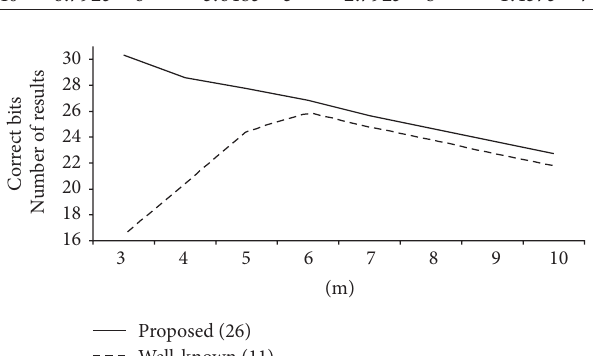
Figure 4: Number of correct bits of result as a function of 𝑚 at 𝑅 = 2 𝑚 and 𝑑 = 24 .